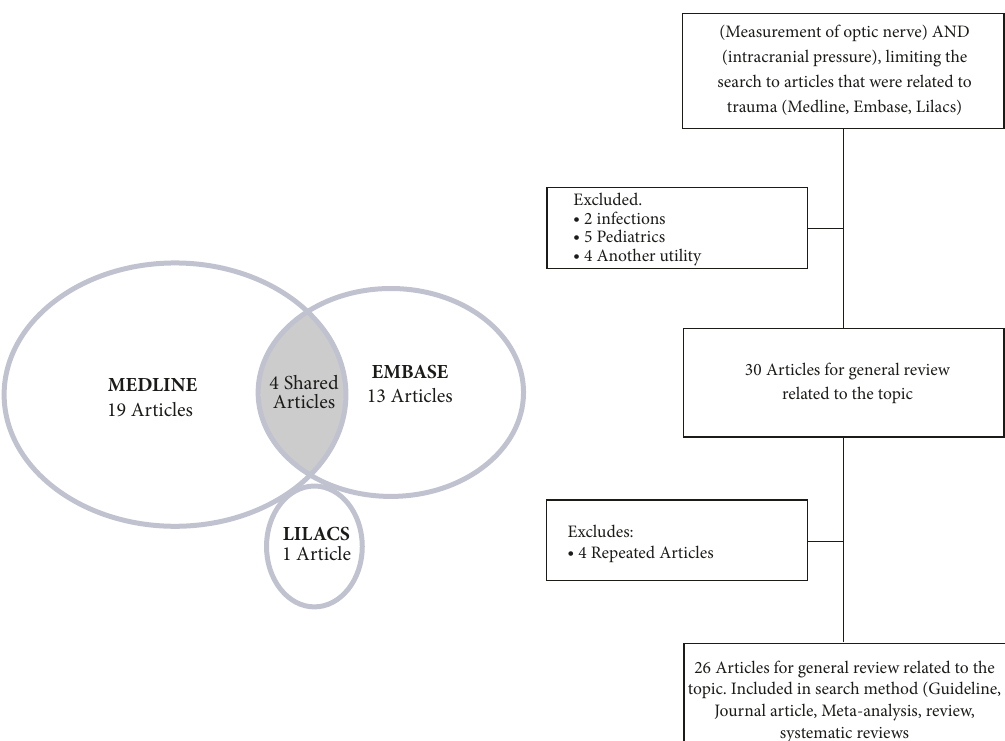
Figure 1: Search methods in